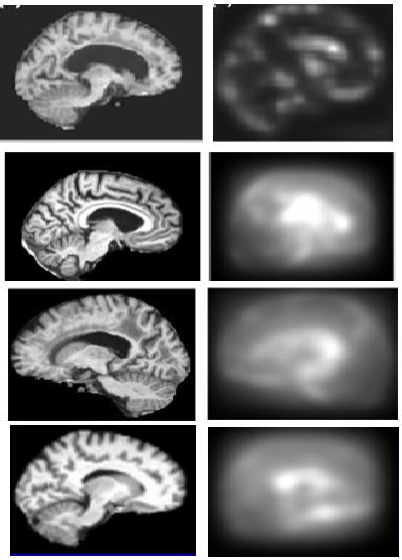
Figure 6. Saliency maps of Alzheimer’s disease MRI images. Figure 6. S aliency maps of Alzheimer’s disease MRI images . Figure 6. S aliency maps of Alzheimer’s disease MRI images .